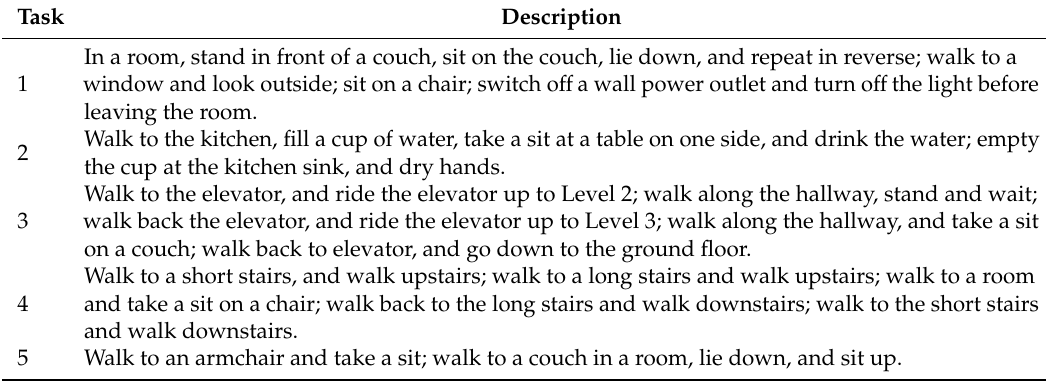
Table A1. Data collection protocol for the free-living activities.